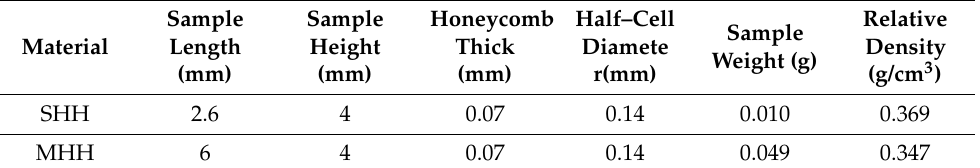
Table 2. The parameters of resin honeycombs. Figure 2. Multi-level honeycomb under SEM.